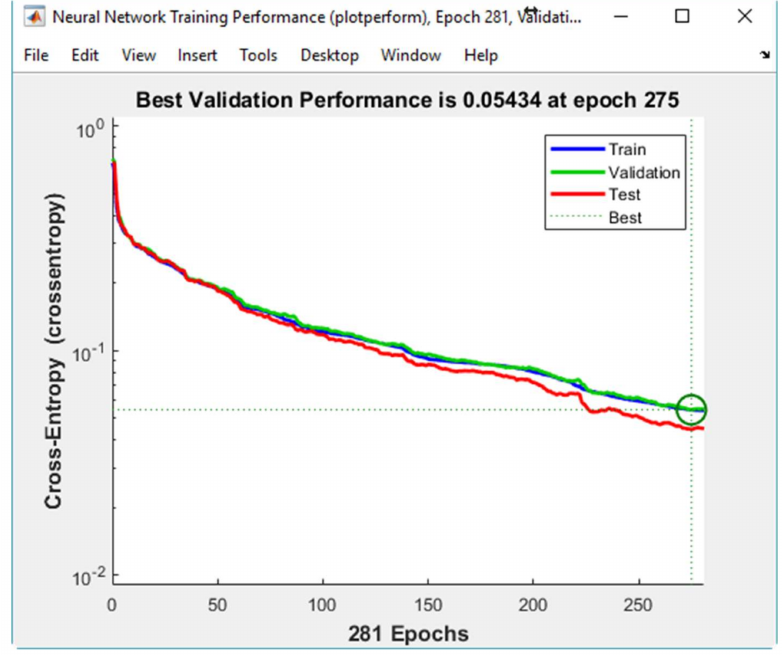
Figure 10. Neural Network Cross-Entropy and Performance plots.